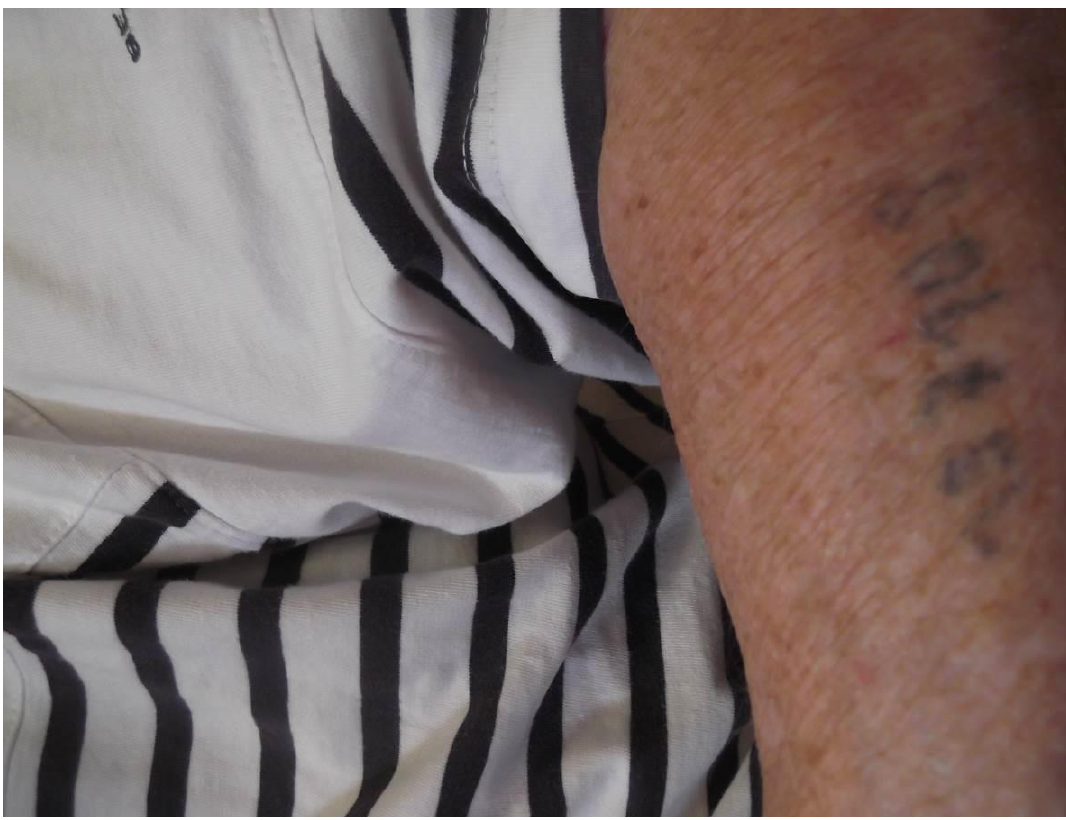
Figure 2: The marks of time. Photograph by the